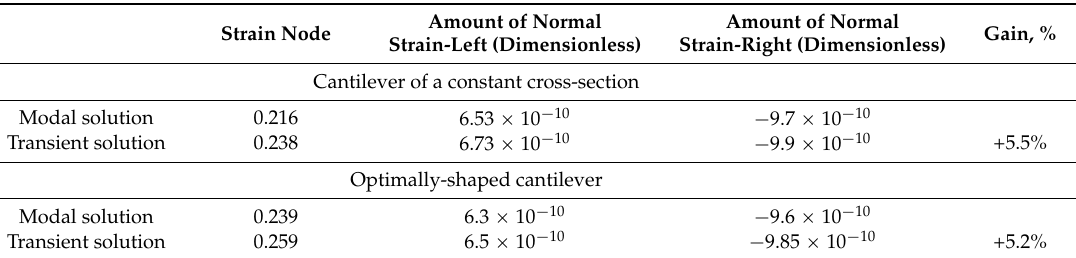
Table 3. Comparison of normal strain amount.